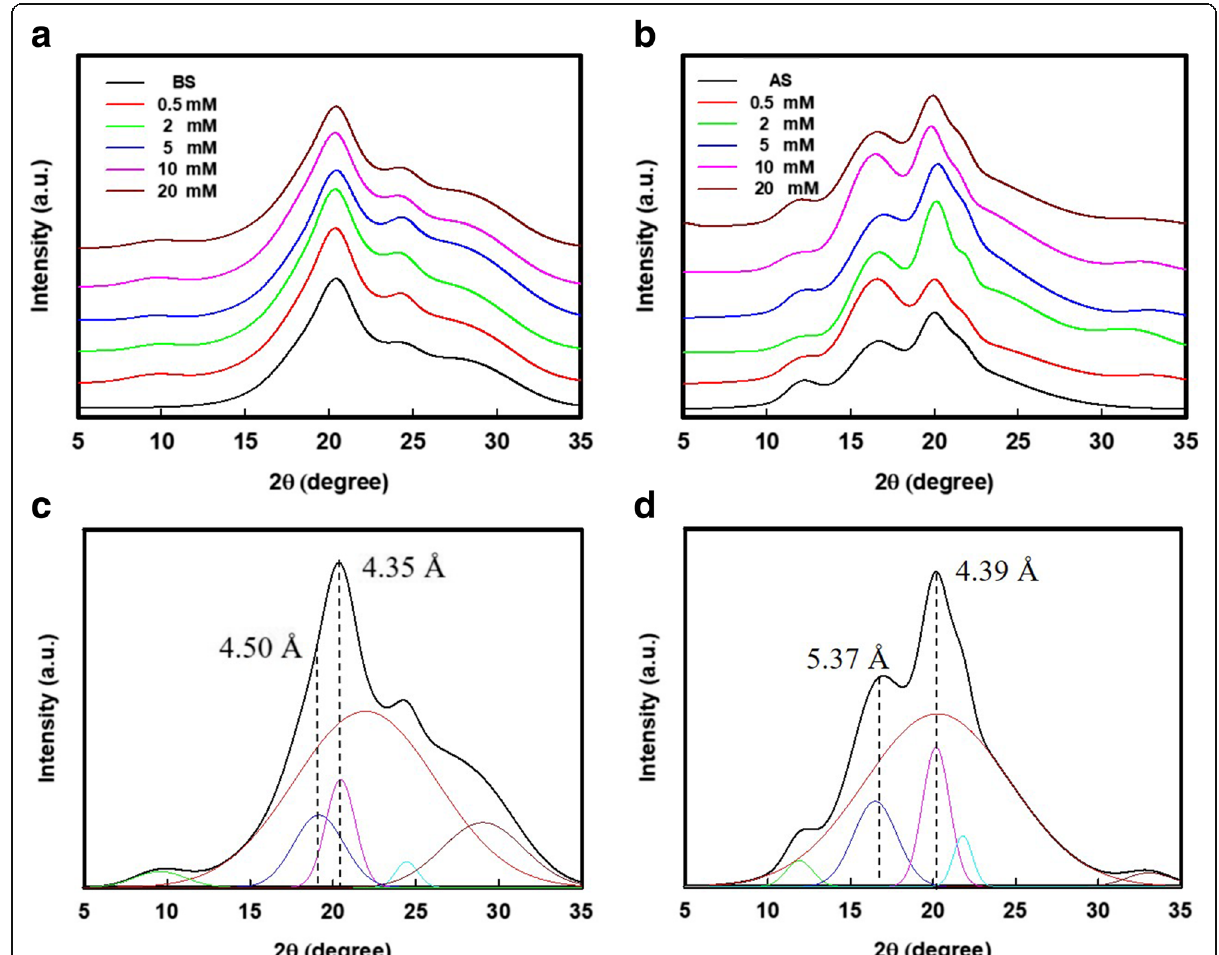
Fig. 3 XRD analysis of the oxidized silk fibers. X-ray diffraction (XRD) pattern of a BS and b AS that oxidized with various NaClO addition. Representative deconvolution and results of c BS and d AS